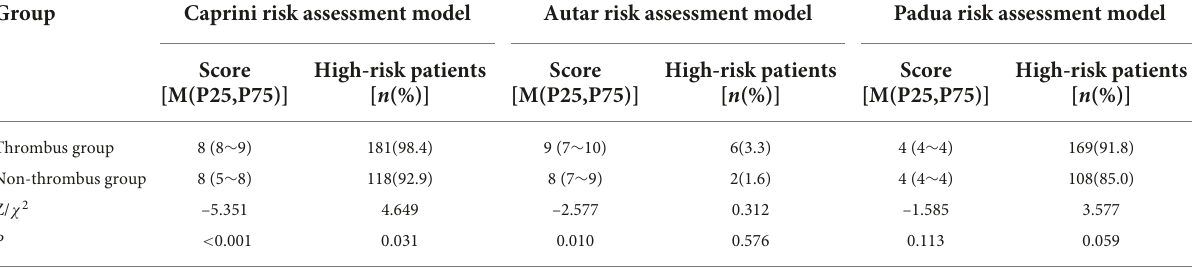
TABLE 2 Comparison of VTE risk scores in patients with poisoning using the three thrombosis risk assessment